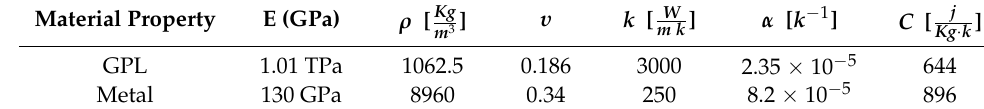
γ ω φ = 30°; GPL = 0.01; =